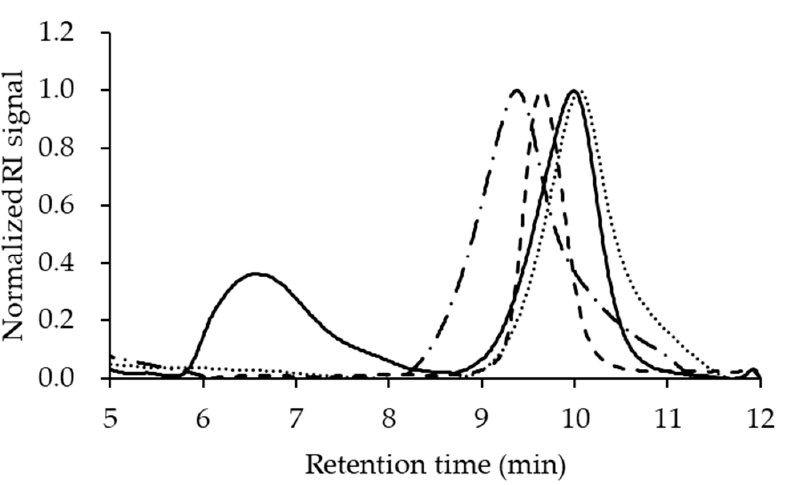
Figure 4. Size-exclusion chromatograms of SC-PEG uni in solvents containing different concentrations of LiBr. Normalized refractive index signals were plotted as a function of retention time. The solid line, dotted line, dashed line, and chain line indicate DMF containing 0 mM, 20 mM, 100 mM, and 300 mM LiBr, respectively.